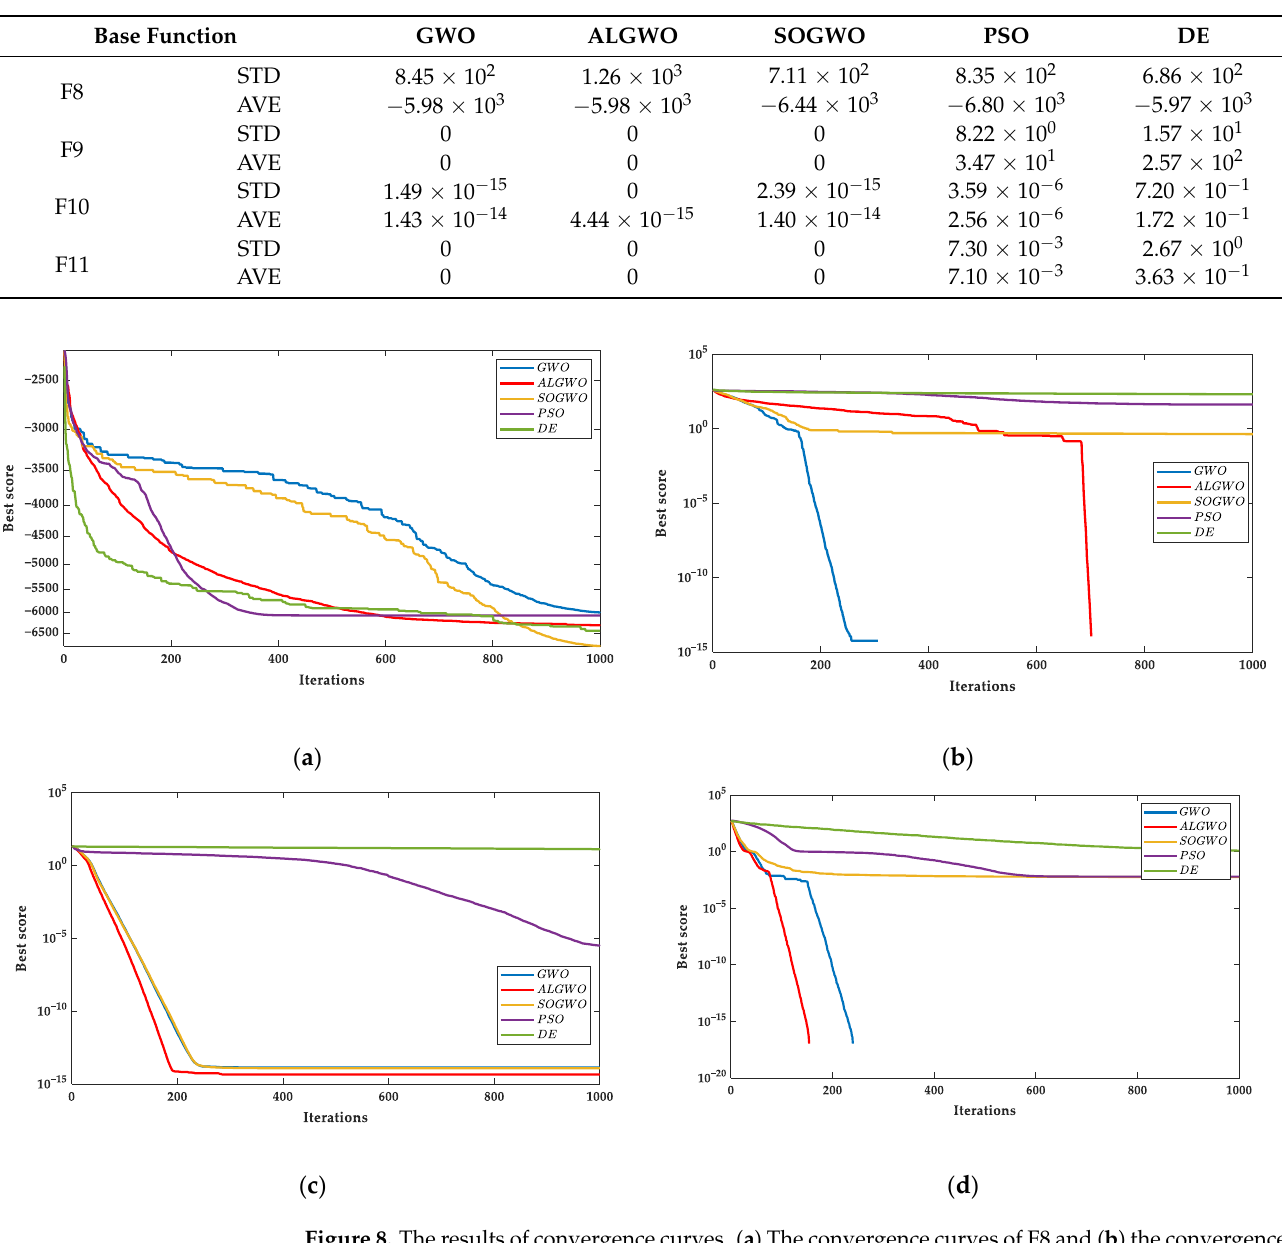
Table 5. Comparison results of five algorithms on four groups of benchmark functions.